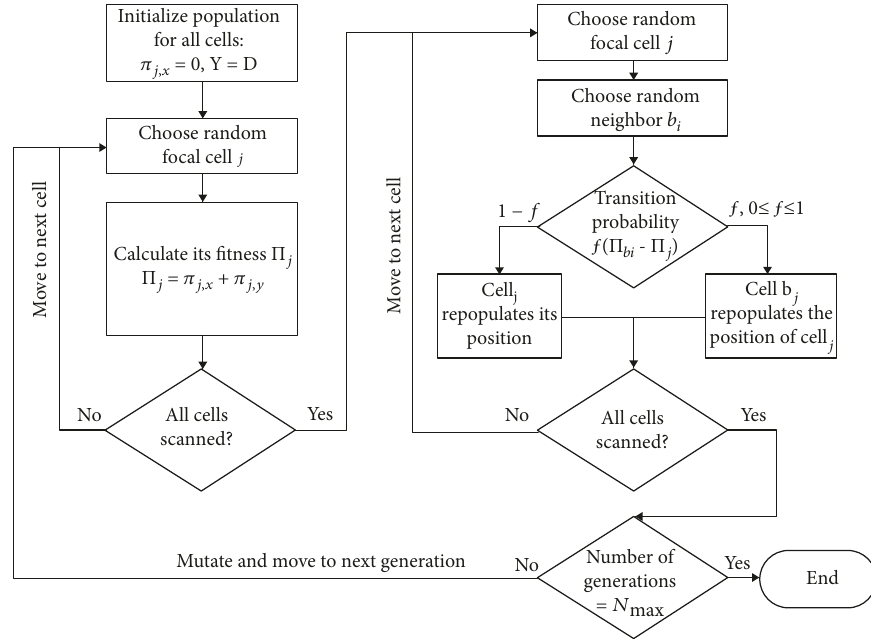
Figure 6: A fl owchart of the spatial prisoner ’ s dilemma